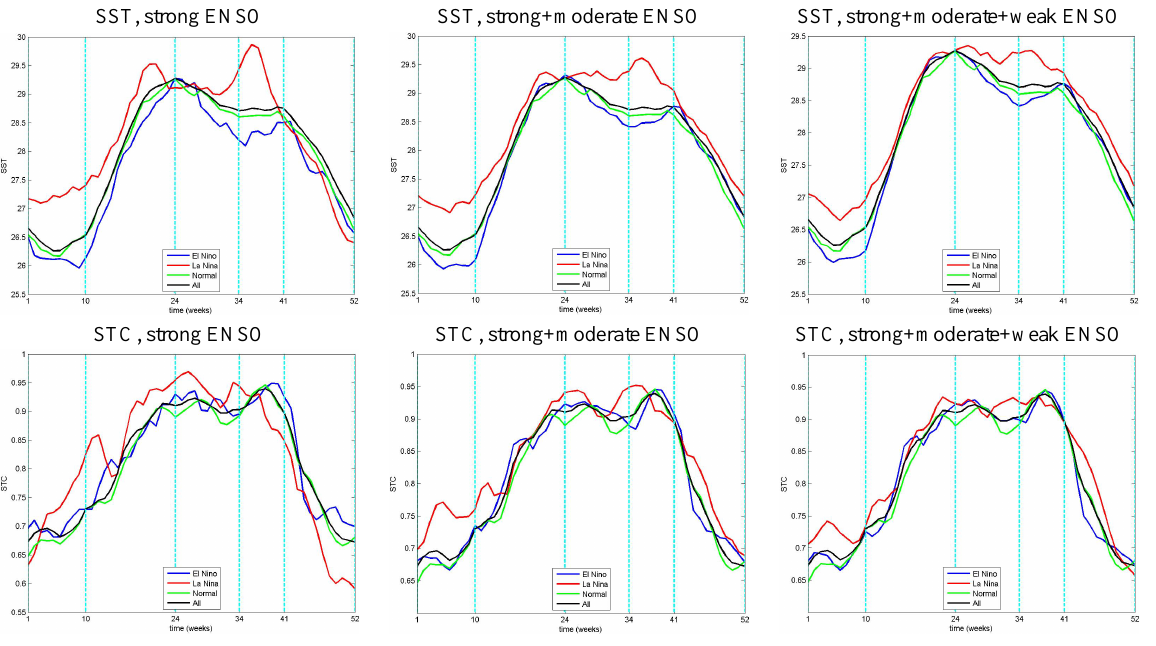
Fig. 8. Yearly average of the SST (top row) and STC values (bottom row). Strong El Ni˜no and La Ni˜na years (left column), strong + moderate (middle column) and strong + moderate + weak ENSO years are used (Table 1). The 399 × 365 Philippine region SST values on each week were averaged, then at each week, the values from all the years were averaged. The same was done for the STC values except there was no need to average over a spatial region. In all plots, the normal and all year groups do not vary. STC parameters: s = 3, c = 3, j = 2, overlapping time-slices.